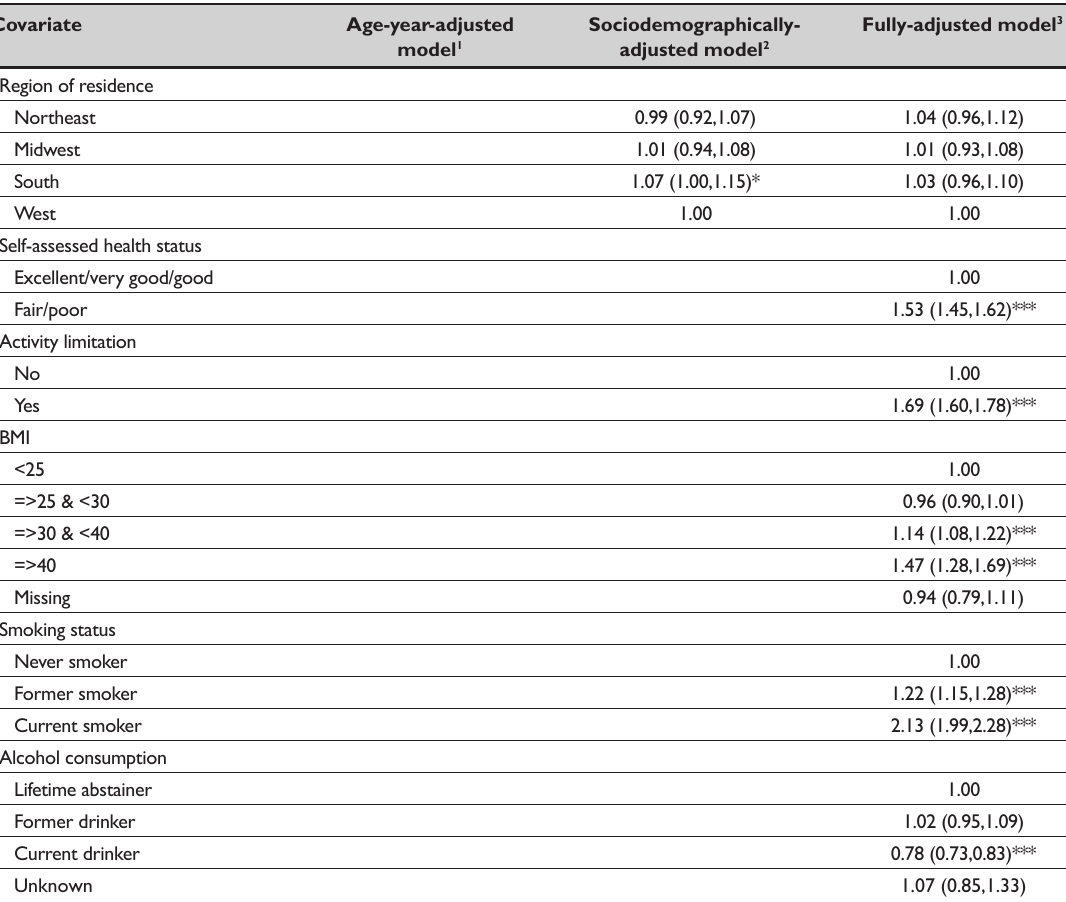
Table 4 provides heart disease mortality risks separately for males and females by psychological distress levels after adjusting for socioeconomic and demograph ic characteristics. For males, the heart disease mortality risk was 179% higher (HR=2.79;